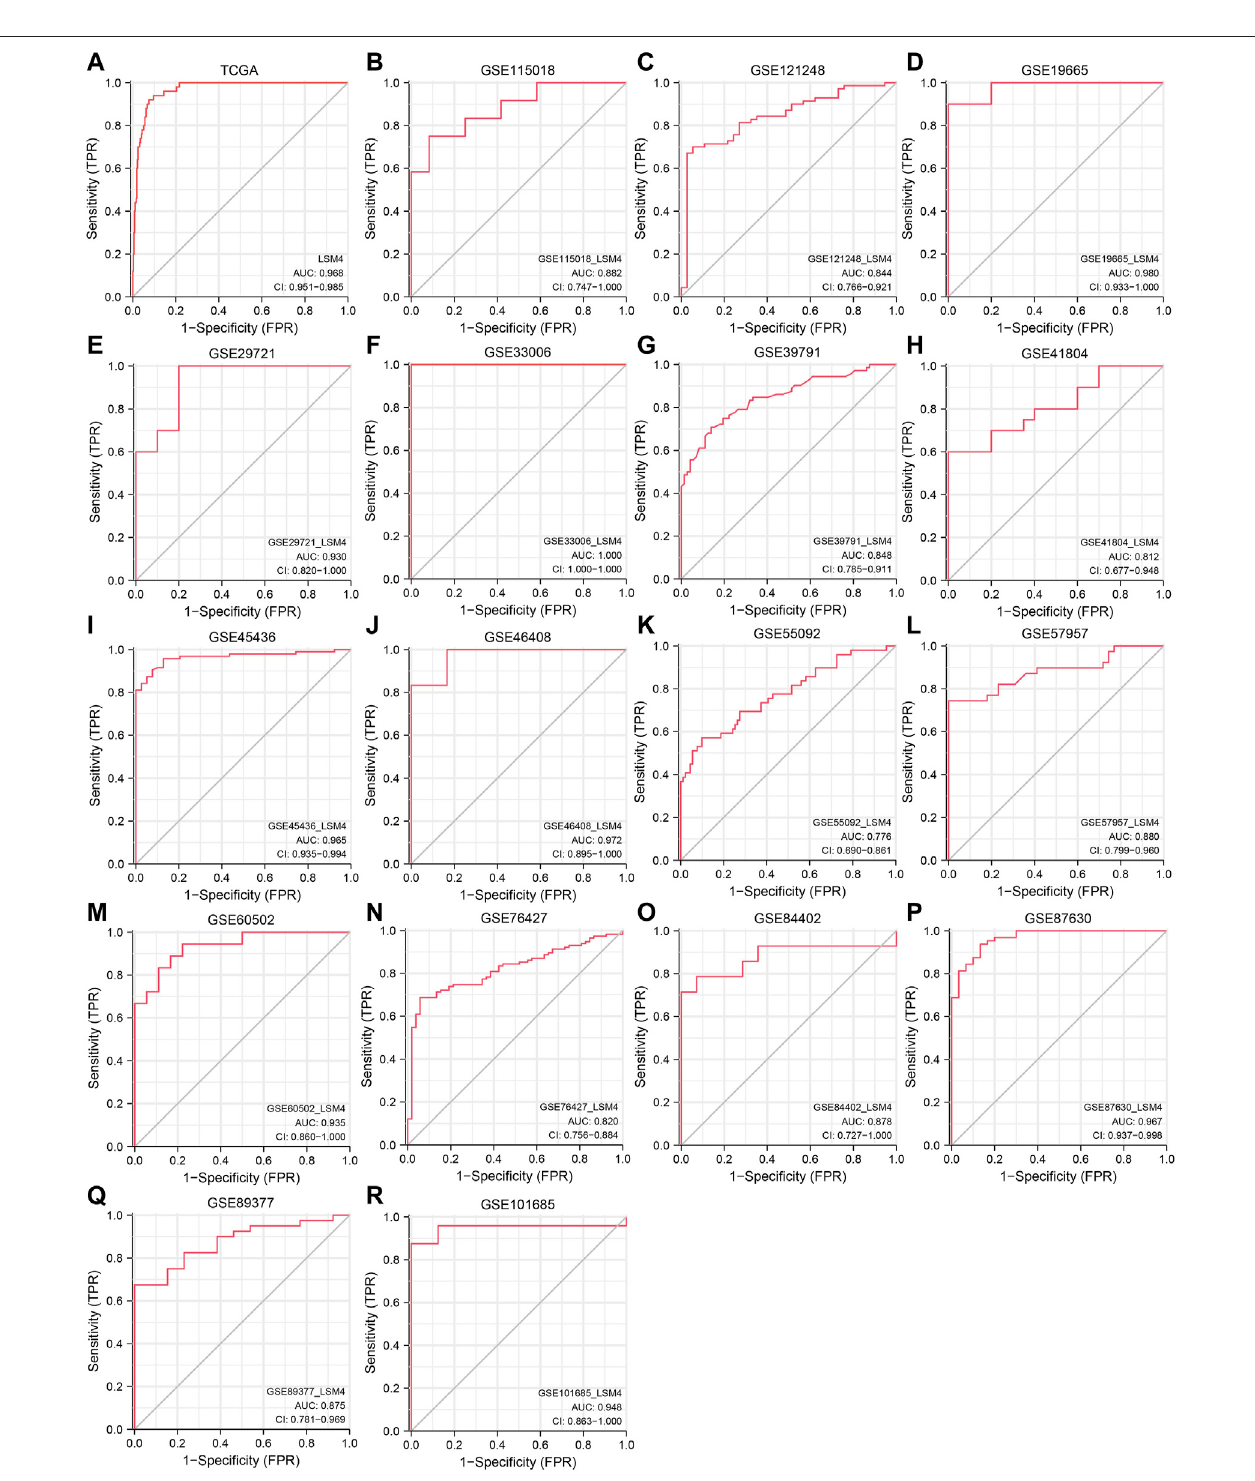
FIGURE4| Diagnosisvalueof LSM4 .Thereceiveroperatingcharacteristic(ROC) curve ofnon-HCC tissuesand HCC tissues.tissues. (A) TCGA. (B) GSE115018. (C) GSE121248. (D) GSE19665. (E) GSE29721. (F) GSE33006. (G) GSE39791. (H) GSE41804. (I) GSE45436. (J) GSE46408. (K) GSE55092. (L) GSE57957. (M) GSE60502. (N) GSE76427. (O) GSE84402. (P) GSE87630. (Q) GSE8937. (R) GSE101685.